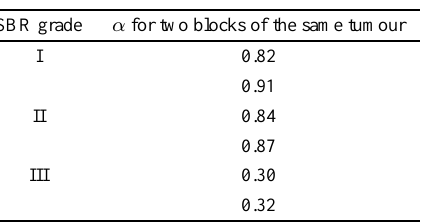
Comparison between estimated values of (cid:11) for two blocks of the same tumour, showing robustness of the estimation of (cid:11) versus block location in the